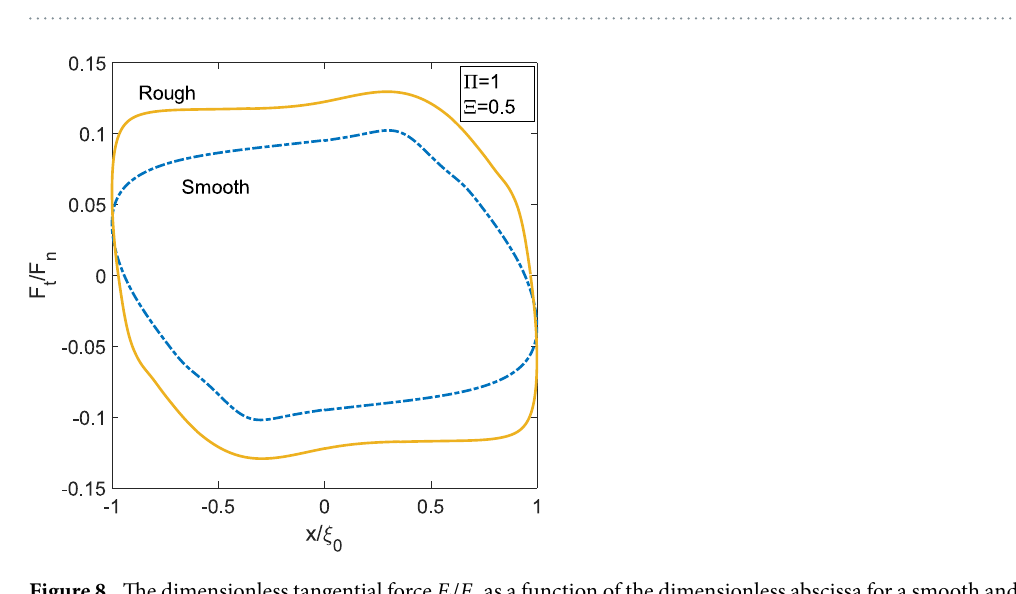
Figure 8. The dimensionless tangential force F t / F n as a function of the dimensionless abscissa for a smooth and a rough